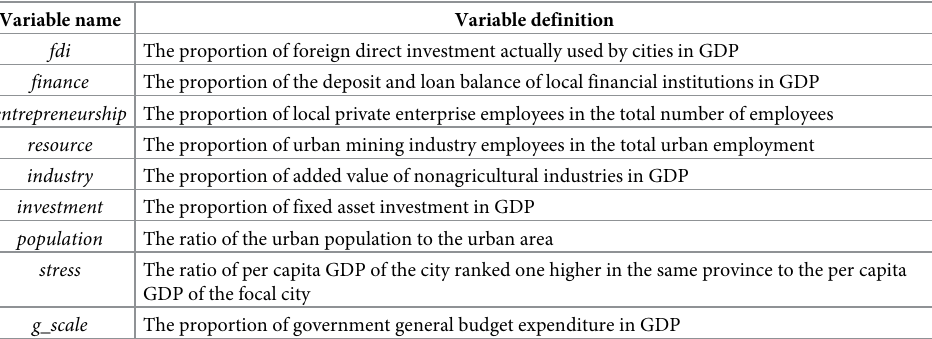
Table 1. Control variable